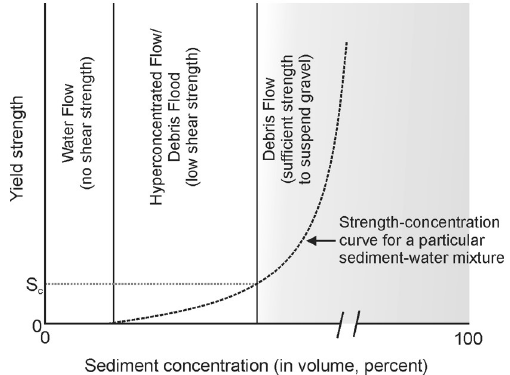
Figure 24. Debris flows as expected to be modeled by DebrisFlow Predictor (shaded area). S C represents the critical shear strength be- yond which gravel (4mm or larger) is suspended. Figure is modified slightly from Pierson